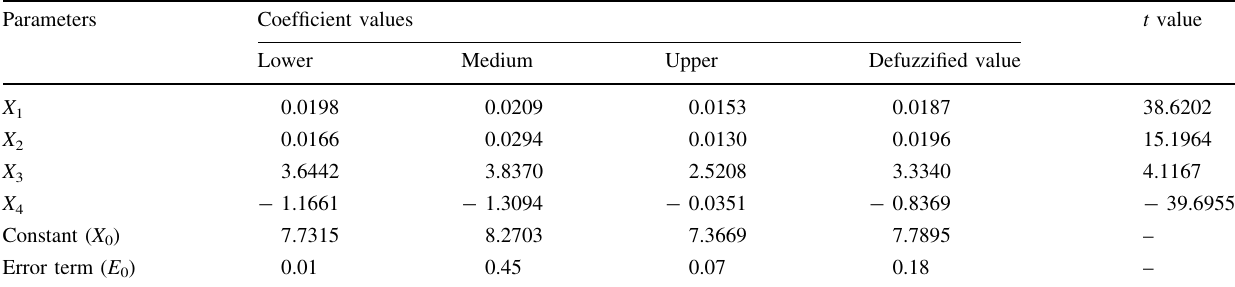
Table 7 Results from FLR analysis